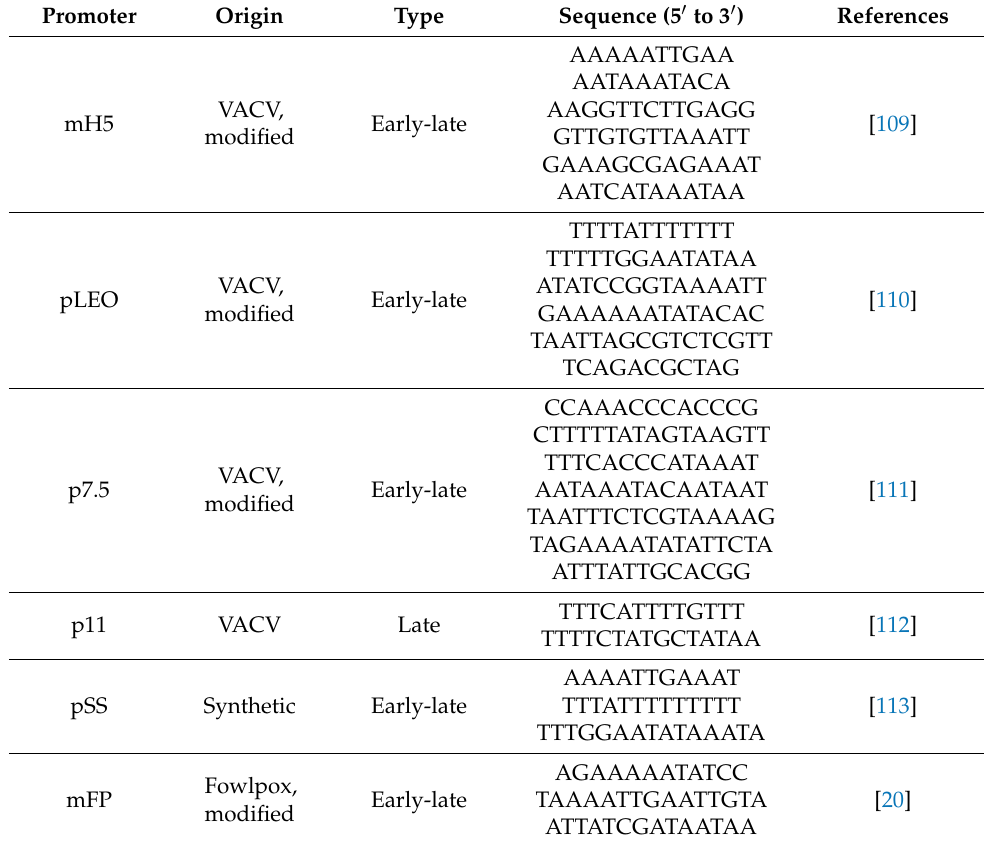
Table 1. Summary of various poxvirus promoters that have been shown to be functional in LSDV.